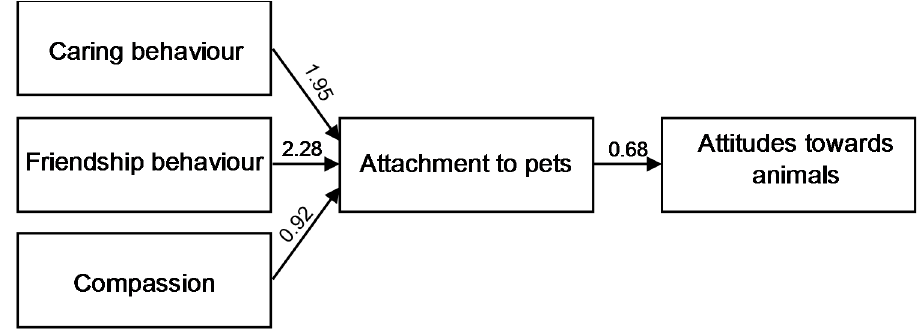
Figure 1. The relationship between attachment to pets and caring behaviour, friendship behaviour, compassion, and attitudes. Unstandardized regression coefficients (ß) are included as demonstrators of strength of the direction. All p < 0.005.